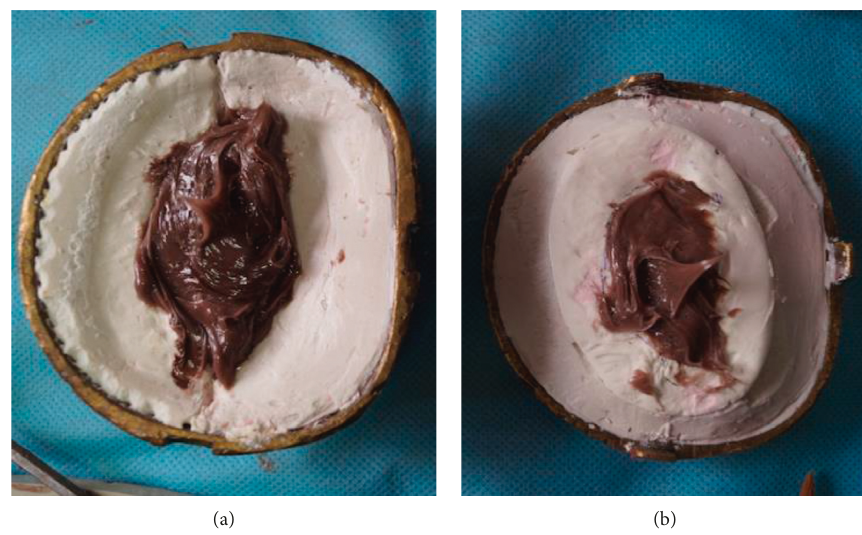
Figure 6: Packing using dark and light shades of RTV